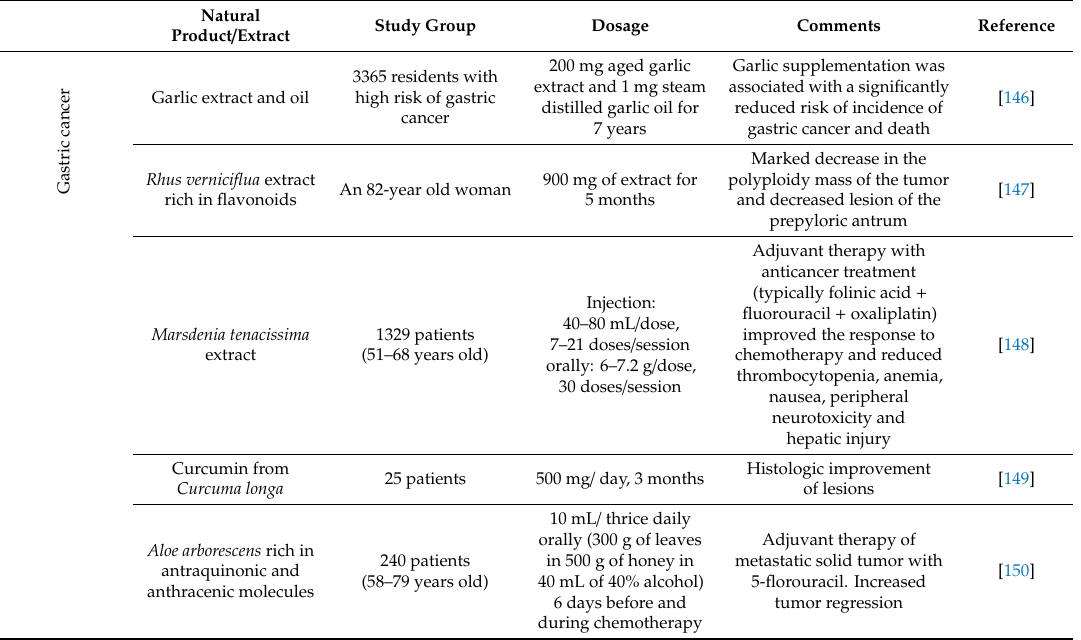
Table 4. The examples of clinical studies on the activity of natural products against gastric cancer in